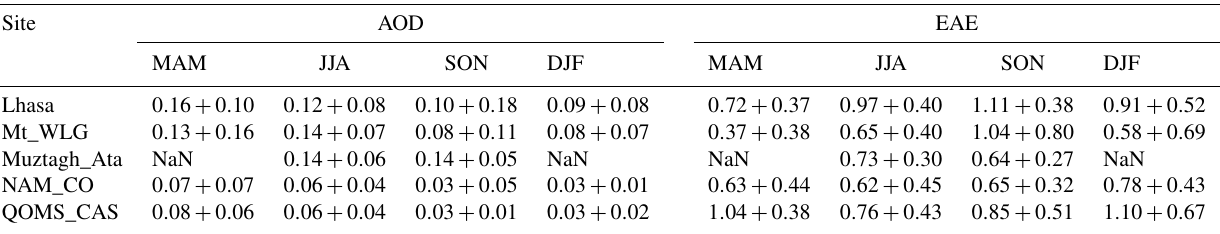
Table 2. Seasonal aerosol optical depth (AOD 440nm ) and extinction Ångström exponent (EAE 440 − 870nm ) from CE318 at the five sites in the